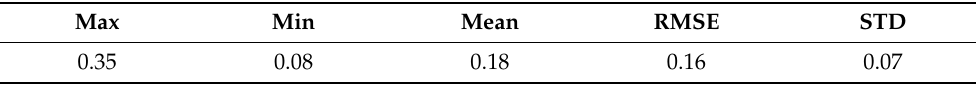
Figure 10. The position error of localization result in longitudinal, lateral, and altitude directions, respectively. Table 2. Localization error compared with groundtruth (units: meter).